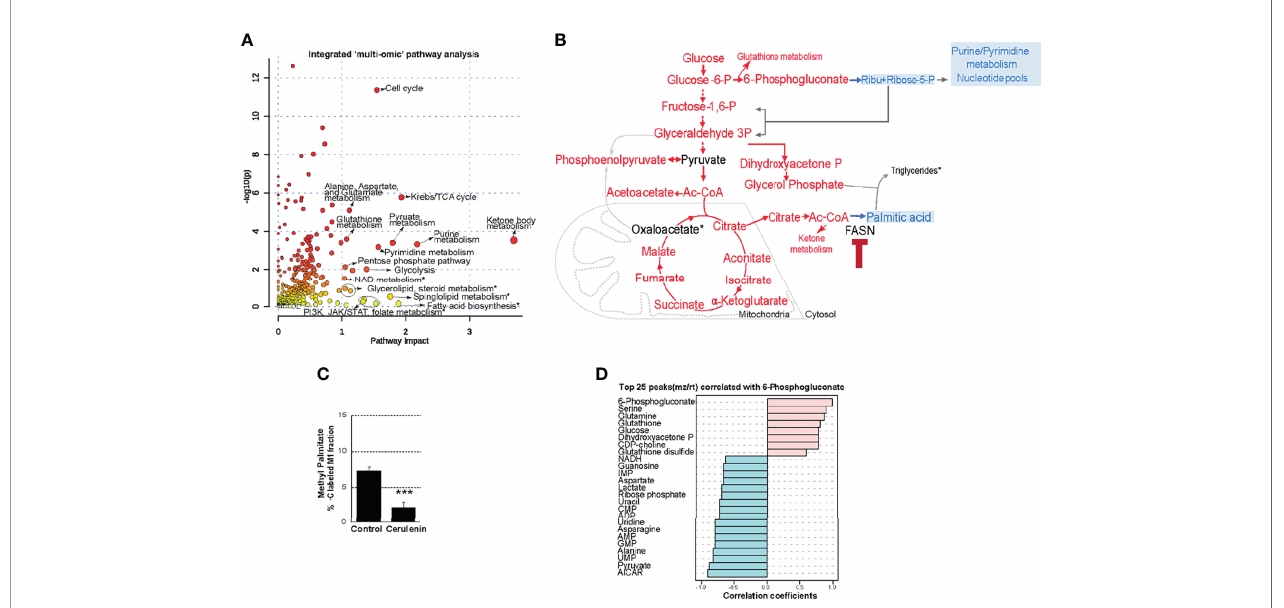
FIGURE 3 | Effects of FASN inhibition on PPP metabolism. (A) Scatter plot representing enriched pathways identi fi ed by integrated multi-omic analysis of cerulenin transcriptome and metabolome, with P -values plotted as -log 10 in y-axis and impact scores on x-axis. Top 20 high impact pathways with impact scores >1, FDR, and P -value cutoff <0.5 are indicated by names. Asterisk denotes non-signi fi cant high-impact pathways below the FDR and P -value cutoff. The complete list of pathways with statistical values from this analysis is included in Supplementary Table S1 . (B) The summary of metabolic changes shown in this fl ow chart indicates the levels of metabolites that “ increased ” (denoted in red) or “ decreased ” (denoted in blue) by cerulenin treatment in SUDHL10 cells. (C) Bar graph representing the percentage of C 13 labeling (x-axis) in the M1 peak of methyl palmitate fractions (y-axis) comparing the control with cerulenin treatment in SUDHL10 cells. Data represented in the bar graph represent averages from experimental triplicates, comparing cerulenin-treated cells with untreated control with P -values <0.001 denoted as ***. (D) Identi fi cation of top 25 metabolites (y-axis) correlating with 6-phosphogluconate level changes associated with FASN inhibition in SUDHL10 cells by Spearman rank correlation and distance measured by